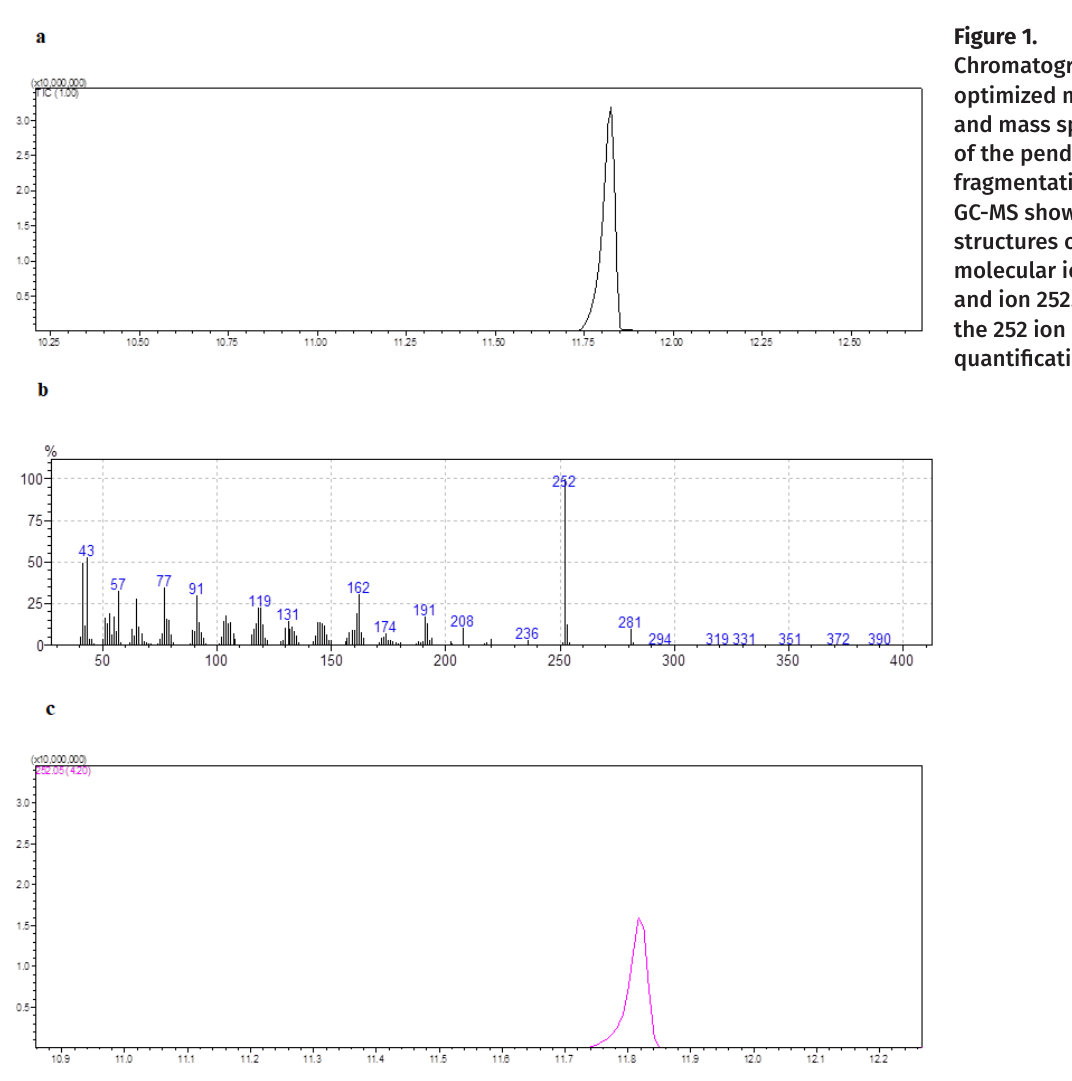
Figure 1. Chromatogram of optimized method (a) and mass spectra (b) of the pendimethalin fragmentation by GC-MS showing structures of the molecular ion (281) and ion 252. Peak of the 252 ion used for quantification